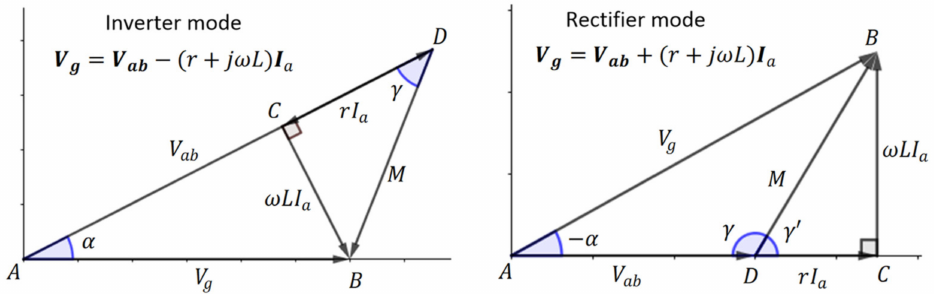
Figure 5. H full bridge converter phasor diagram for both rectifier and inverter modes. √ M = I a r 2 + ω 2 L 2 is the magnitude of the inductor voltage phasor. From these phasor diagrams, the phase angle of the modulator, α , is obtained by calculating its tangent with the triangle ABC, as shown in Equation